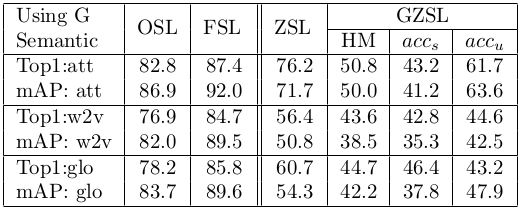
Table from the paper: A Unified approach for Conventional Zero-shot, Generalized Zero-shot and Few-shot Learning
Table text:
UsingG
OSL
FSL
ZSL
GZSL
Semantic
HM
acc s
acc u
Top1:att
82.8
87.4
76.2
50.8
43.2
61.7
mAP:att
86.9
92.0
71.7
50.0
41.2
63.6
Top1:w2v
76.9
84.7
56.4
43.6
42.8
44.6
mAP:w2v
82.0
89.5
50.8
38.5
35.3
42.5
Top1:glo
78.2
85.8
60.7
44.7
46.4
43.2
mAP:glo
83.7
89.6
54.3
42.2
37.8
47.9